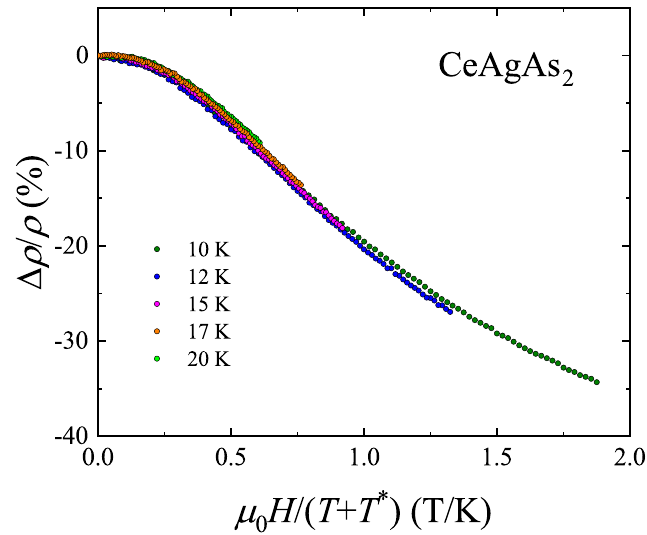
Figure 10. Single-ion Kondo scaling of the transverse magnetoresistance of single crystalline CeAgAs 2 measured with j ⊥ [ 010 ] and H ⊥ [ 010 ]